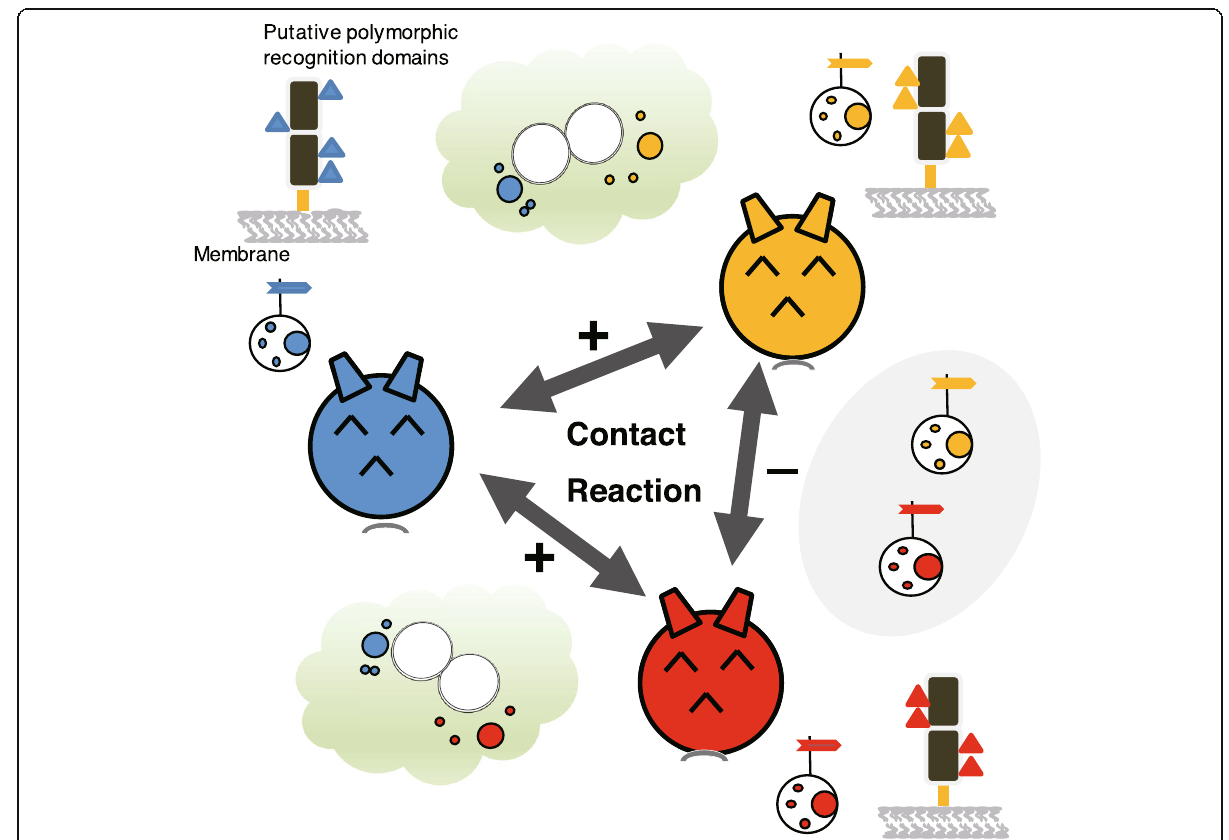
Fig. 6 Overview of the process for identification of self-markers. CR is induced in 85% of contacts between individuals. Self-markers are likely membrane proteins with polymorphic recognition domains. The triangles showed polymorphic recognition domains. The patterns of the domains are different between CR induced individuals and similar between CR non-induced